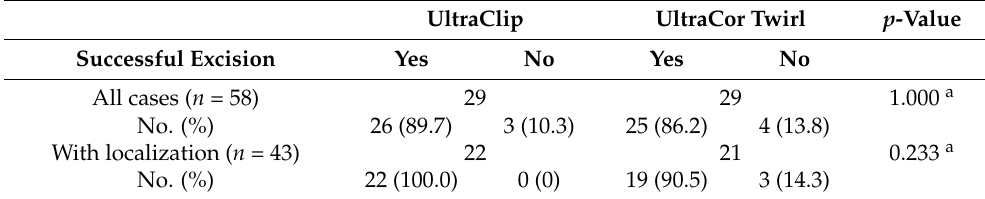
Table 3. Successful excision rates between the two tissue